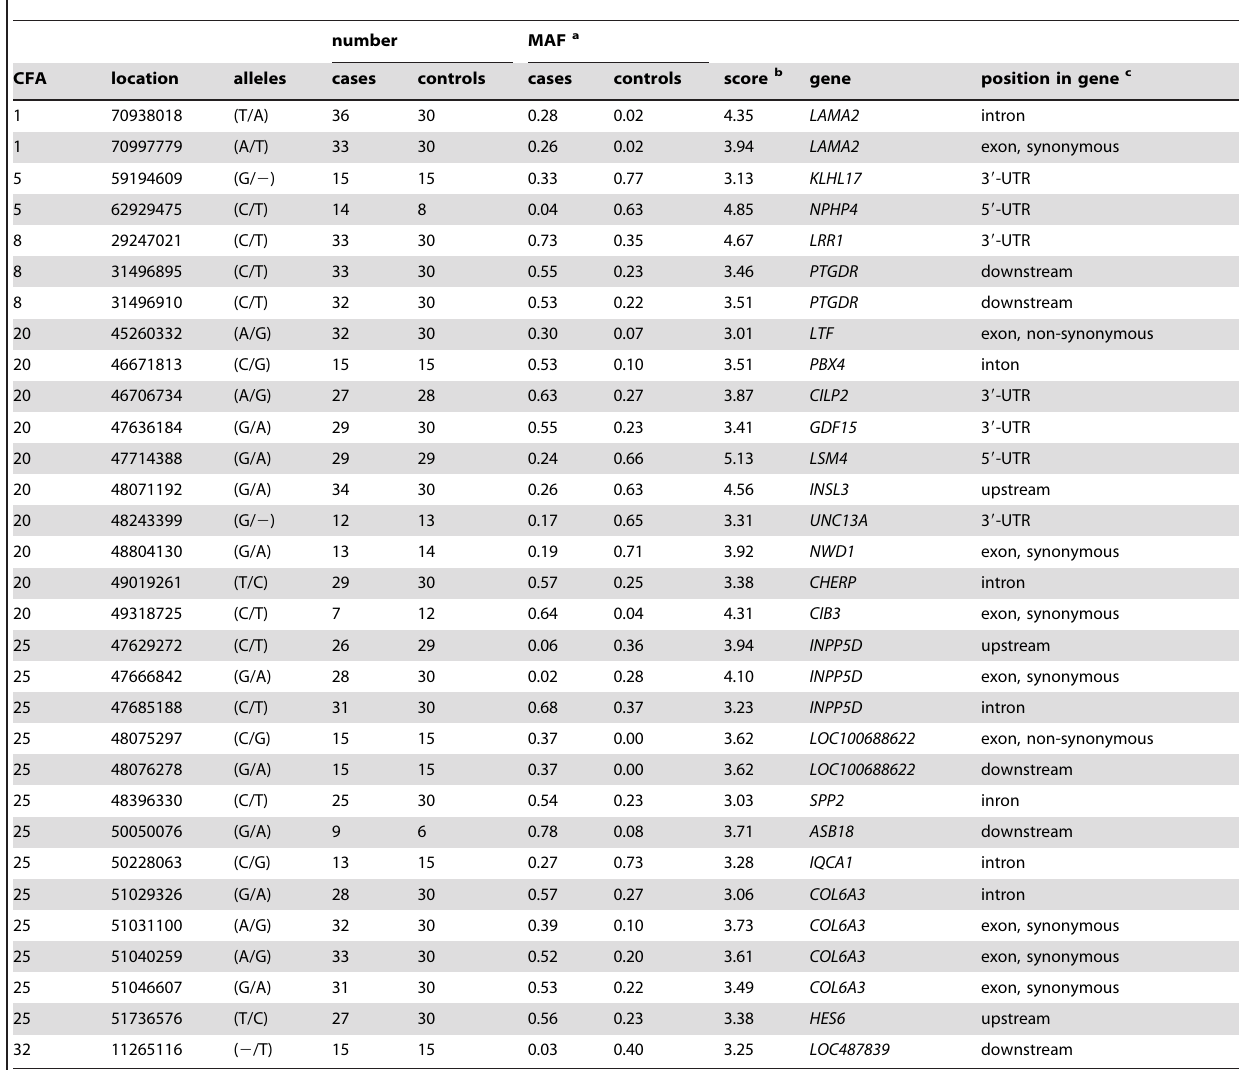
Table 2. Variant DNA sequences associated with hip dysplasia in Labrador